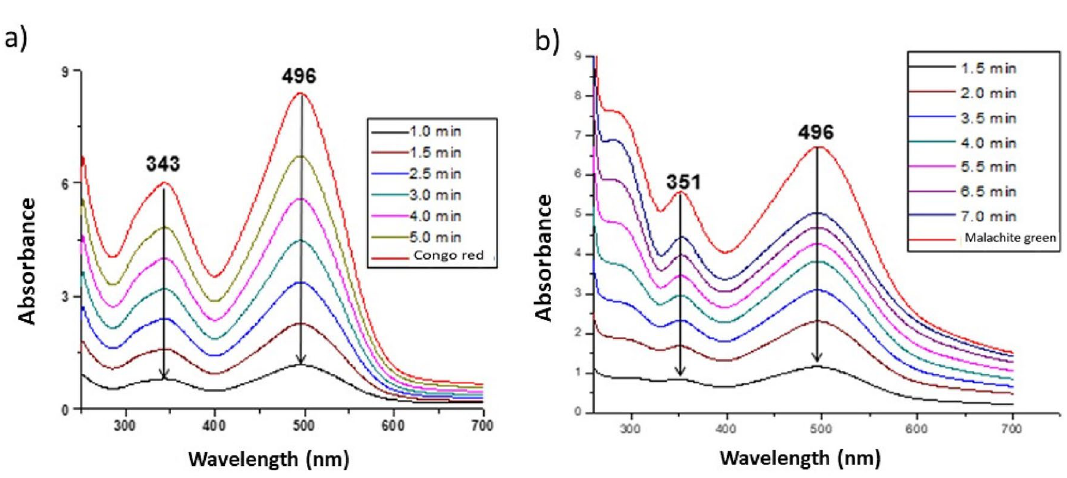
Figure 6. Study of kinetics of the ( a ) congo red and ( b ) malachite green dye degradation by the synthesized gradually decreased over time. The absorption peak disappeared and the color of the solution changed from red to colorless. Regarding the degradation percentages, we observed a value of 86.61% for congo red and 82.11% for malachite green, observing a significant decrease in dye degradation from the first contact (Fig. 7).